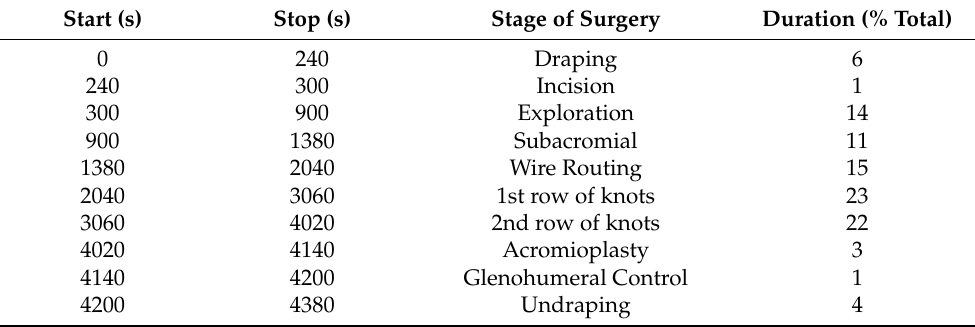
Table 2. Description of surgical stages, their corresponding time and % of surgical